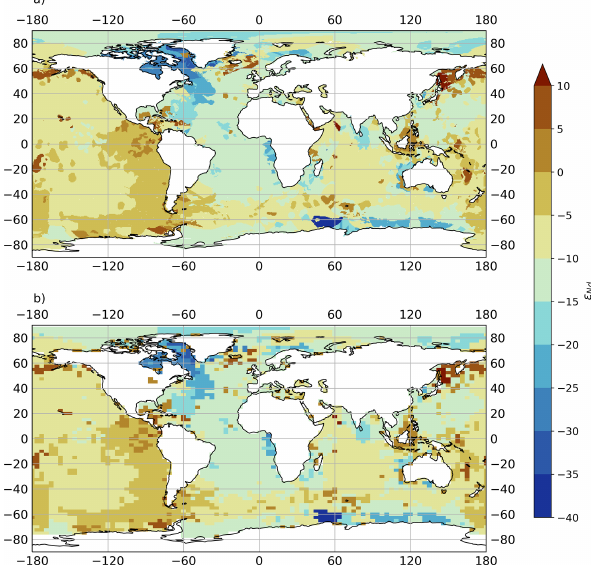
Figure 6. (a) Map of the global ε Nd distributions at the sediment– ocean interface from Robinson et al. (2021) and (b) as used as a model input in this study (bi-linearly regridded from (a) onto the coarser FAMOUS ocean